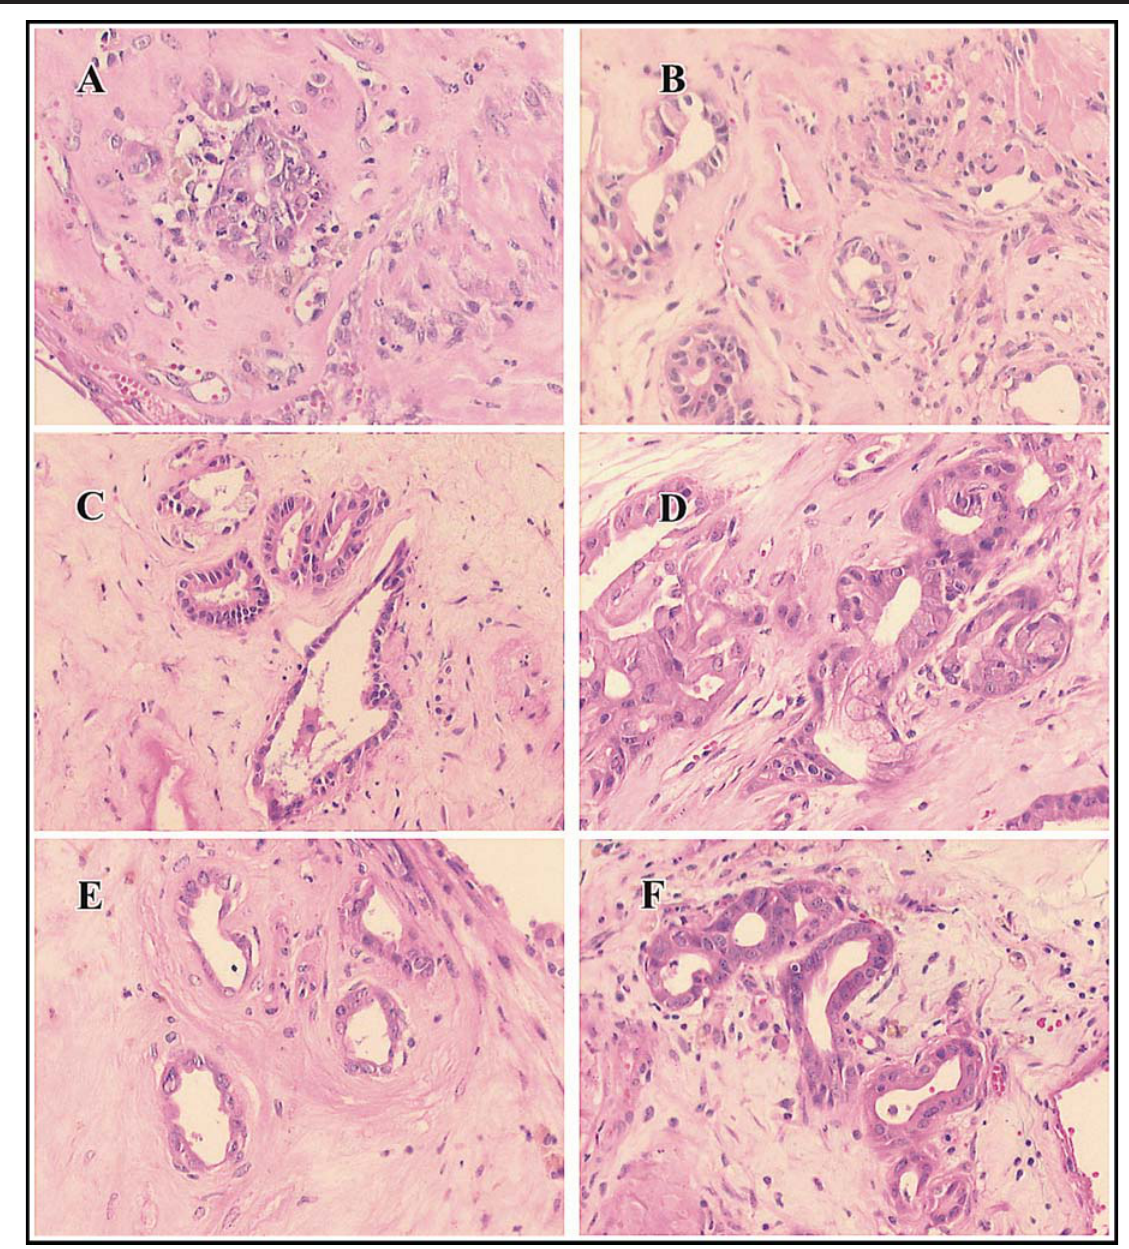
FIGURE 2 - Histological sections pointing out invasive pancreas adenocarcinoma. A) Animal from alcohol group, magnification of ×20 from the original; B) Animal from alcohol + caffeine group, magnification of ×20 from the original; C) Desmoplasic stroma with atypical glands, magnification of ×20 from the original; D) Animal from alcohol group, magnification of ×20 from the original; E) and F) Desmoplasic stroma with atypical glands, magnification of ×20 from the original. Slides stained using the hematoxylin and eosin technique